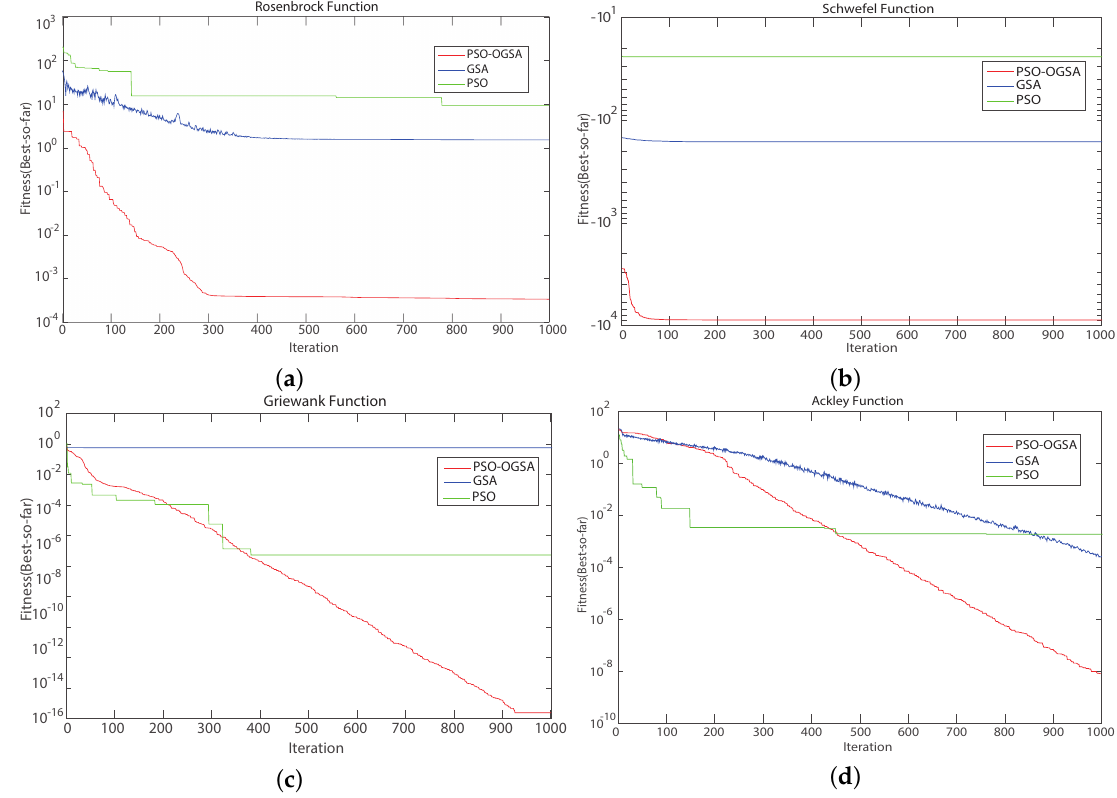
Figure 4. Comparative convergence behaviors of the PSO-OGSA, PSO and GSA for some benchmark test functions, ( a ) the Rosenbrock function, ( b ) the Schwefel function, ( c ) the Griewank function, and ( d ) the Ackley